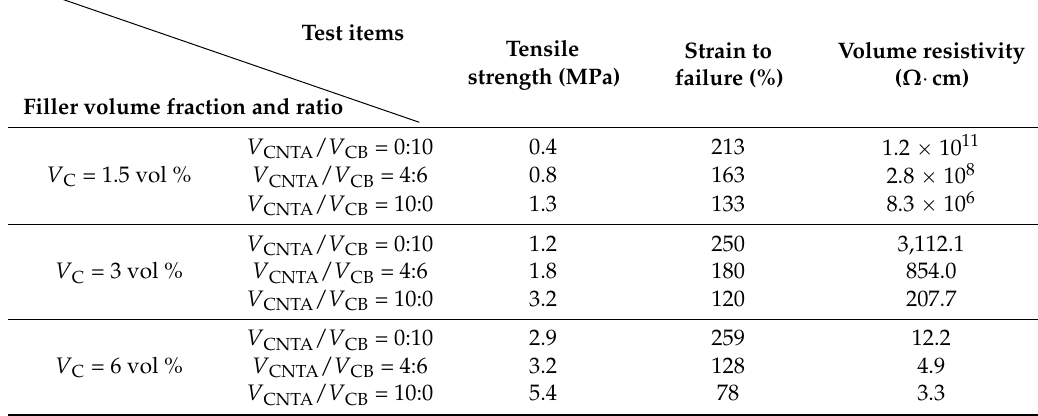
Table 1. Values for measured electrical and mechanical properties of different composites. V c represents the total volume fraction of fillers in the composite, and V CNTA and V CB refer to the volume fraction of CNTAs and CB in the composite, respectively.